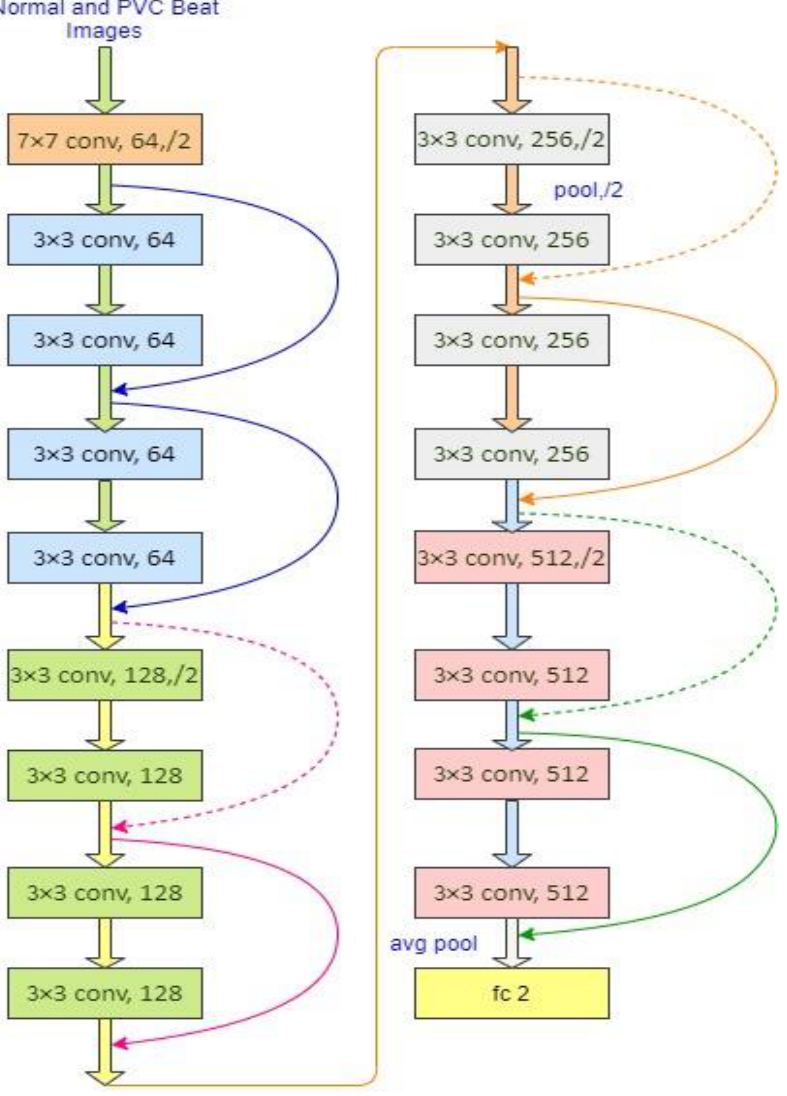
Figure 3. ResNet-18 network architecture, the dotted shortcuts represent the enhancement of the dimensions.